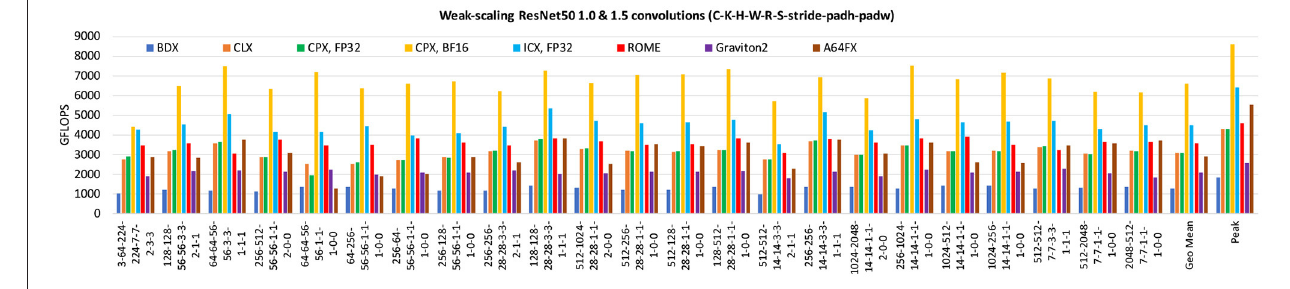
FIGURE 21 | Convolutions via BRGEMM TPP.